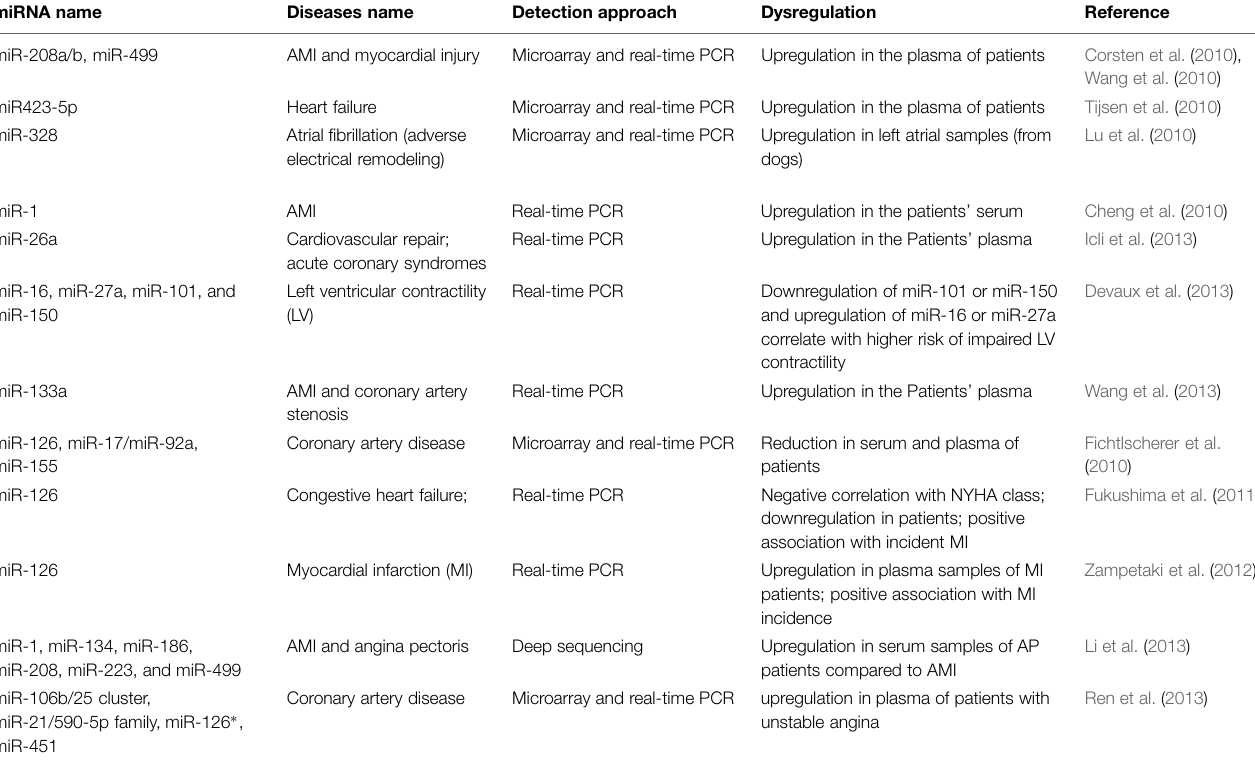
TABLE 1 | List of cardio-miRs involved with different cardiovascular